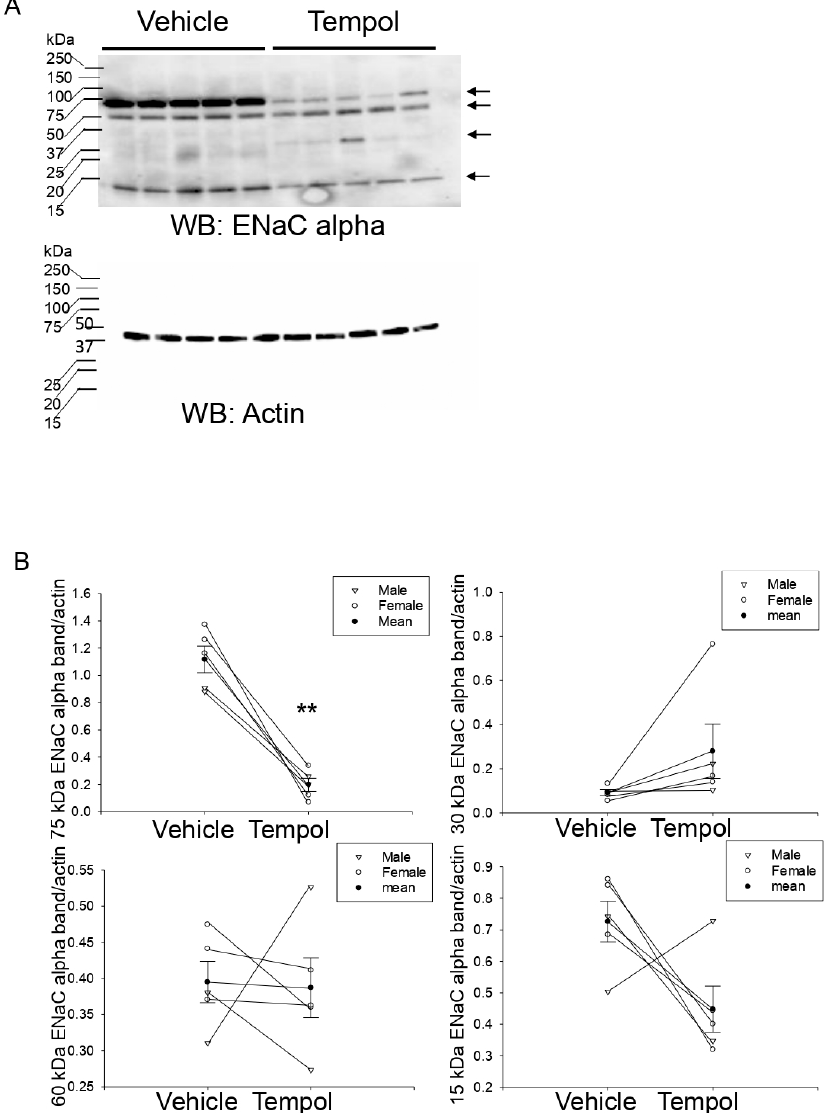
Figure 6. Western blot analysis of ENaC alpha protein expression in renal kidney cortex tissue of hypertensive 129Sv mice infused with vehicle or Tempol: ( A ) Western blot of ENaC alpha protein expression in kidney cortex samples from salt-induced hypertensive 129Sv mice infused with either vehicle or Tempol. ( B ) Densitometric analysis of the immunoreactive ENaC alpha band normalized to the actin band shown in panel A. N = 5 mice per group. A paired t -test was performed and the p -value was 0.063 for the 30 kDa band. ** represents a p -value oof